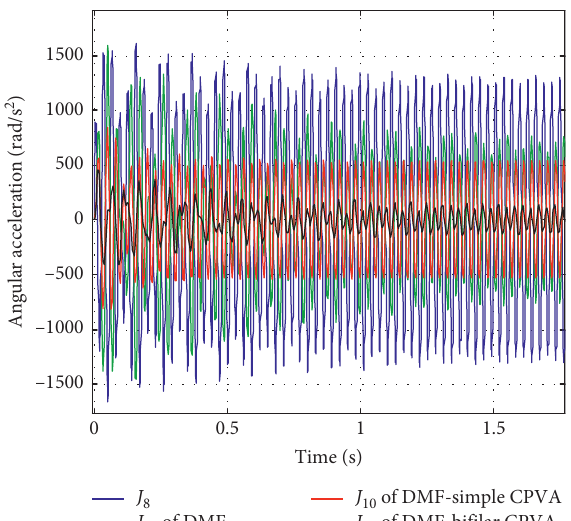
Figure 10: Angular acceleration curves of J of engine speed. Figure 8: Angular acceleration curves of J 8 and J 10 at 1000r/min of